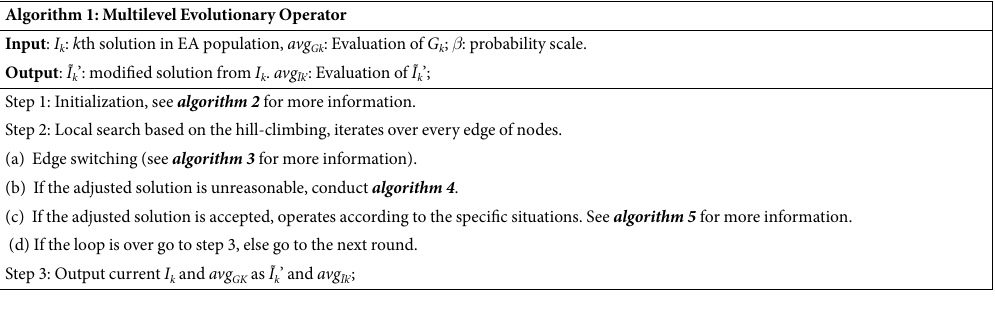
Algorithm 2: Initialization